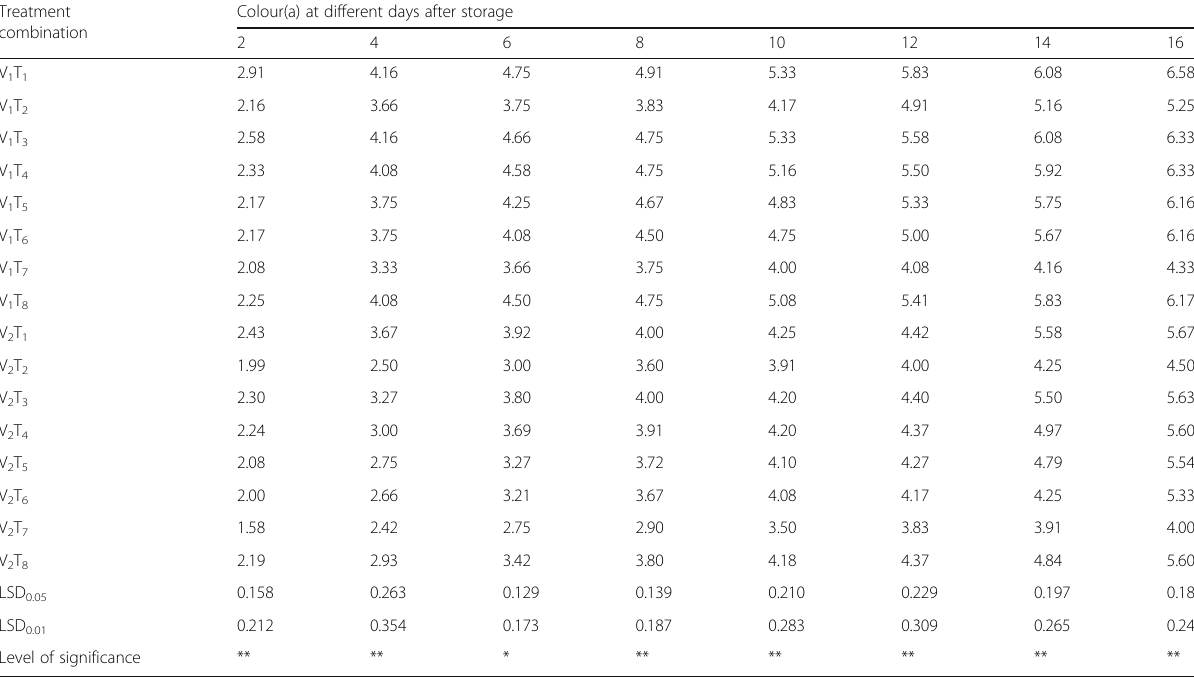
a Color score ( 1 green, 2 breaker, 3 turning, 4 pink, 5 light red, 6 red, 7 red ripe) *Significant at 5% level of